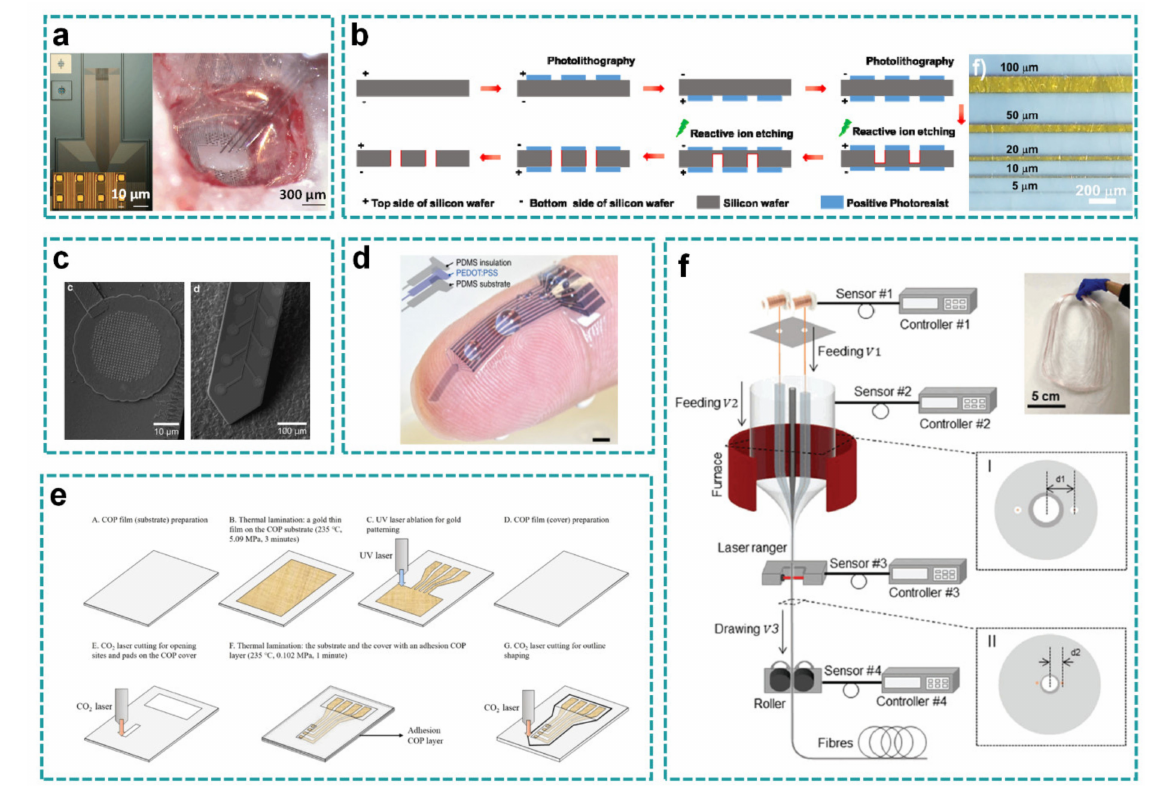
Figure 6. High resolution. ( a ) the NeuroGrid fabricated with conventional photolithography has an electrode Scheme 10 µ m × 10 µ m and an interelectrode spacing of 30 µ m (reprinted with permission from [68]); ( b ) a Si shadow mask combined with electron beam evaporation and chemical vapor deposition technology (reprinted with permission from [78]); ( c ) a polymer probe with 32 recording sites by an improved electron beam lithography (EBL) process of polymer substrate (reprinted with permission from [102]); ( d ) a simple CO 2 laser machining process of a neural probe based on the cyclic olefin polymer (COP); scale bar, 1 mm (reprinted with permission from [103]); ( e ) 3D printable conducting polymer ink based on poly(3,4-ethylenedioxythiophene):polystyrene sulfonate (PEDOT:PSS) for 3D printing of conducting polymers as neural probe (reprinted with permission from [77]); ( f ) the composite flexible multimode optical fiber probe fabricated by a strategy of compound scaling and shrinking process (reprinted with permission from